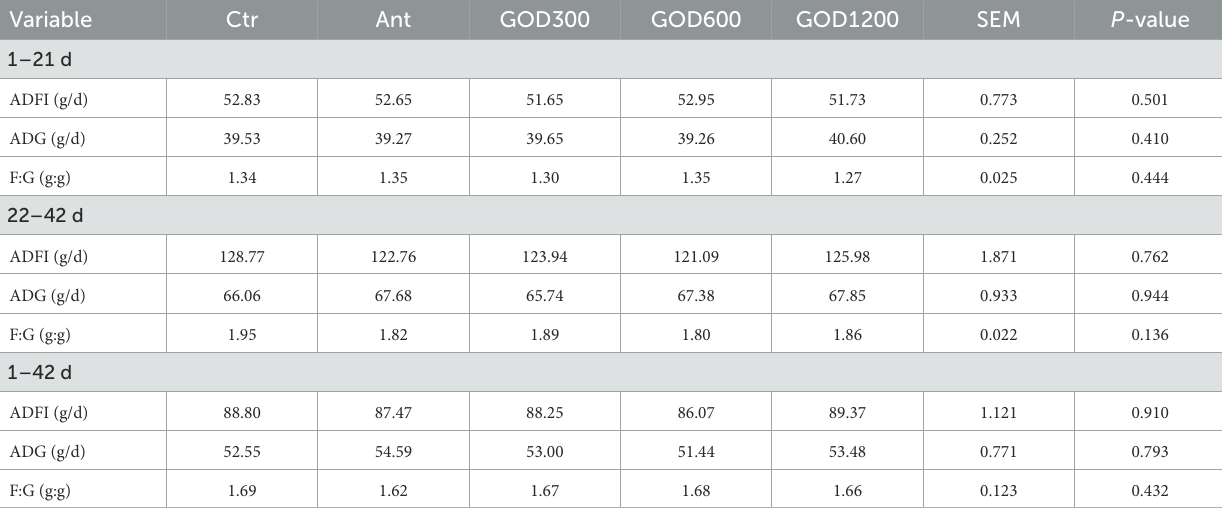
TABLE 3 Effect of GOD on the growth performance of broilers (mean ± SEM, n = 6).